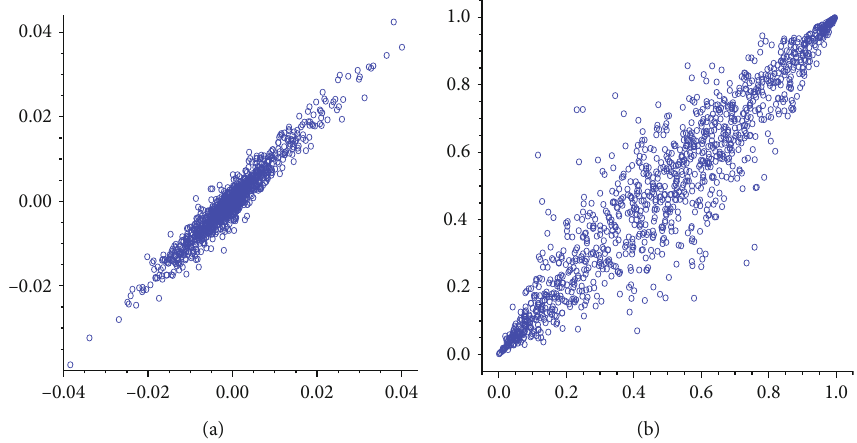
Figure 13: The scatter plot of the negative daily log-returns of the S&P 500 index versus the Dow Jones index (a) and their transformations into uniformly distributed data (b) that have both upper and lower tail